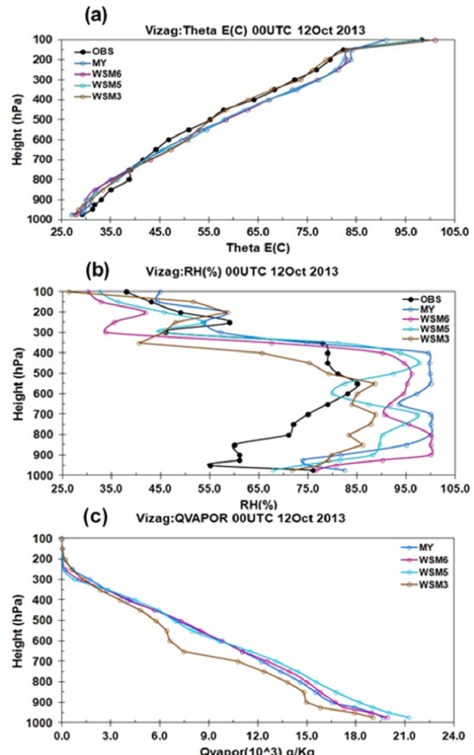
Figure 9. Vertical profiles of ( a ) equivalent potential temperature (°C), ( b ) relative humidity (%), and ( c ) water vapor mixing ratio (gmkg − 1 ) derived at Visakhapatnam meteorological station valid at 00 UTC, 12 October 2013.